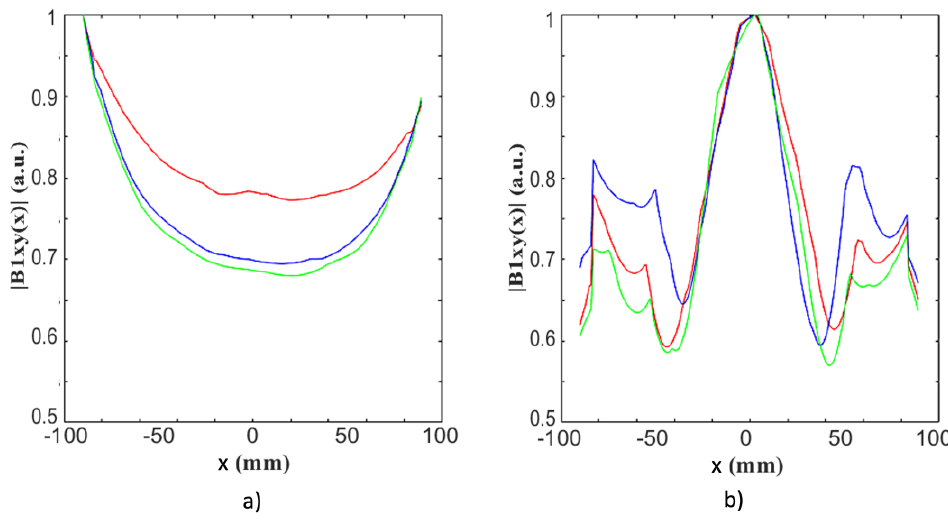
Figure 8 . Transverse | 𝑩 𝟏+ | profiles along the x -axis at the sodium ( a ), and proton ( b ), Larmor frequency of the 7 T four-ring DT-RF coil model for the ‘long’ (red line), ‘short’ (blue line) and ‘intermediate’ (green line) configurations.